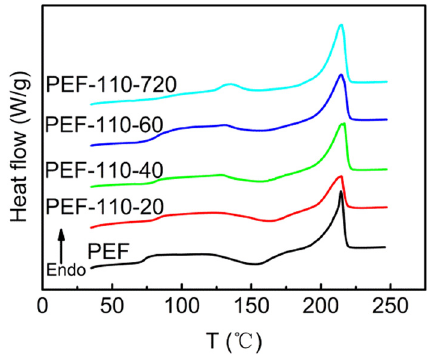
Figure 4: XRD patterns of PEF - 110 - t . Figure 5: DSC heating curves of PEF